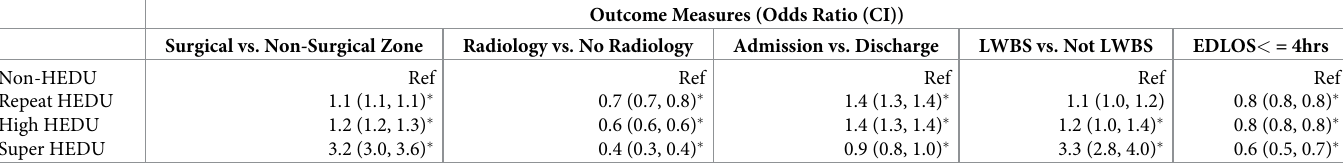
Outcome Measures (Odds Ratio (CI))